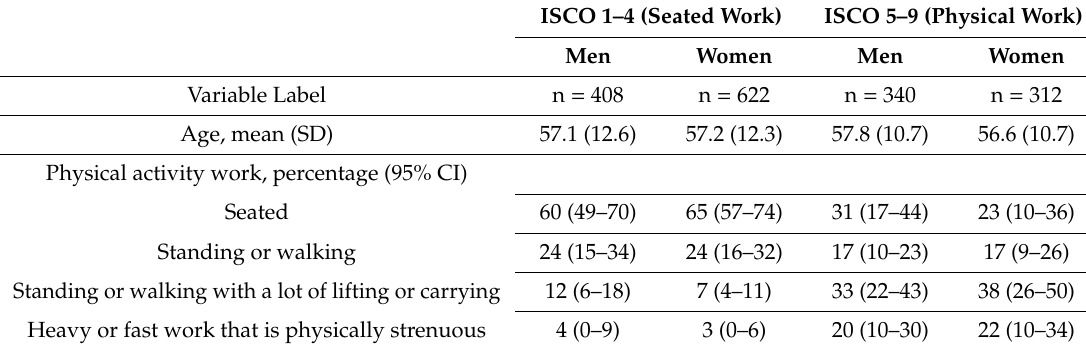
Table 1. Characteristics of the population and work characteristics in ISCO groups 1–4 (mainly seated) and 5–9 (mainly physically demanding work).